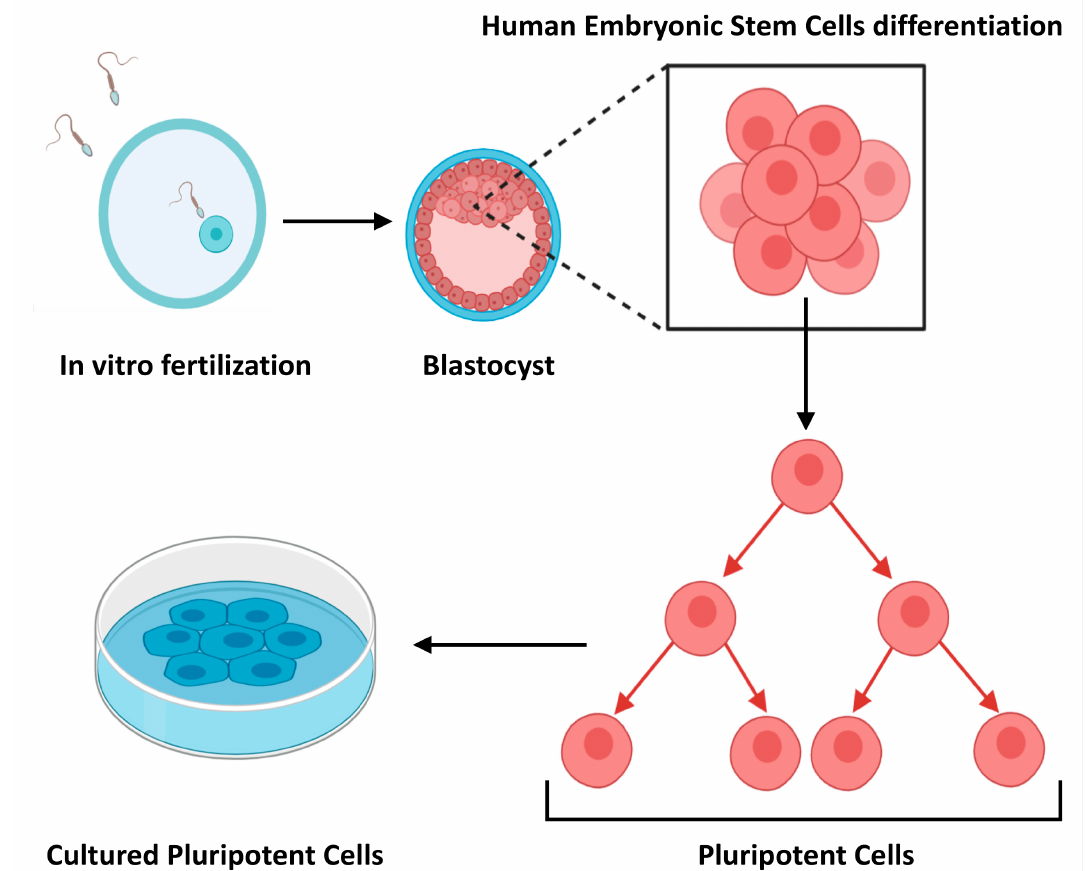
Figure 1. Schematic representation of how embryonic stem cells are